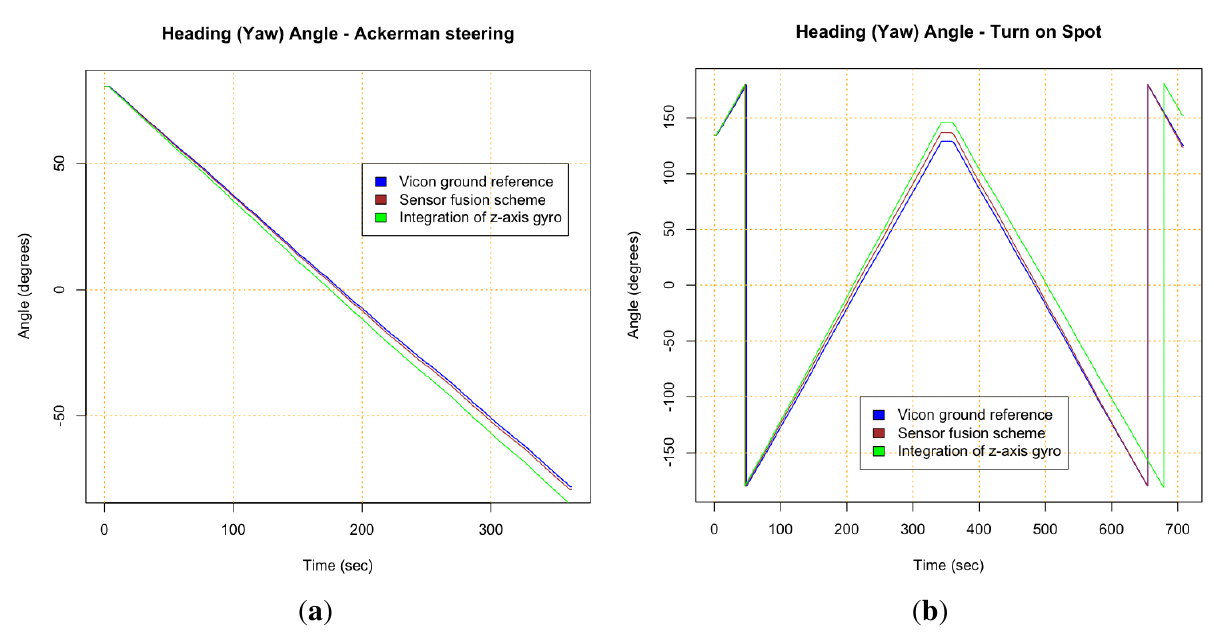
Figure 10. Results of the proposed approach for turning maneuvers as Ackerman and Turn-on-Spot. ( a ) Heading for Ackerman steering trajectory; ( b ) Heading for Turn-on-Spot test.